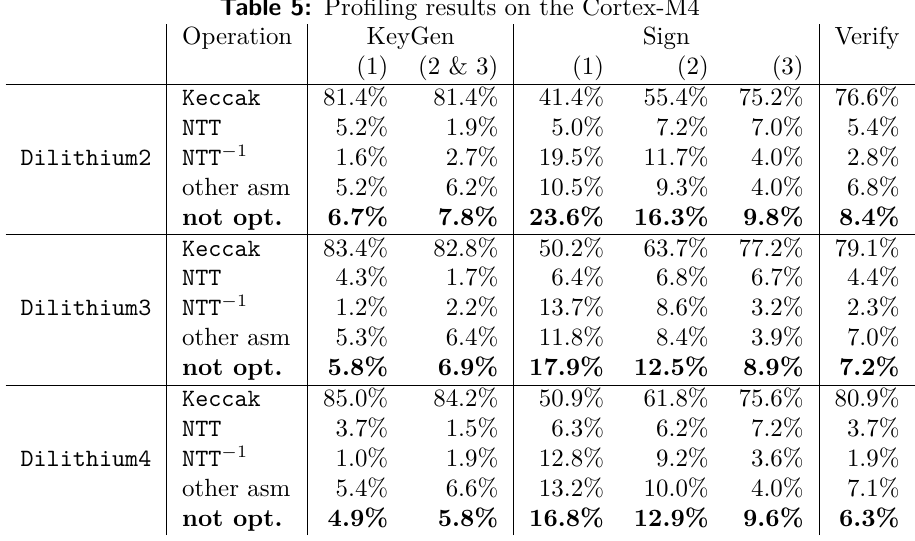
Table 5: Profiling results on the Cortex-M4 Operation KeyGen Sign